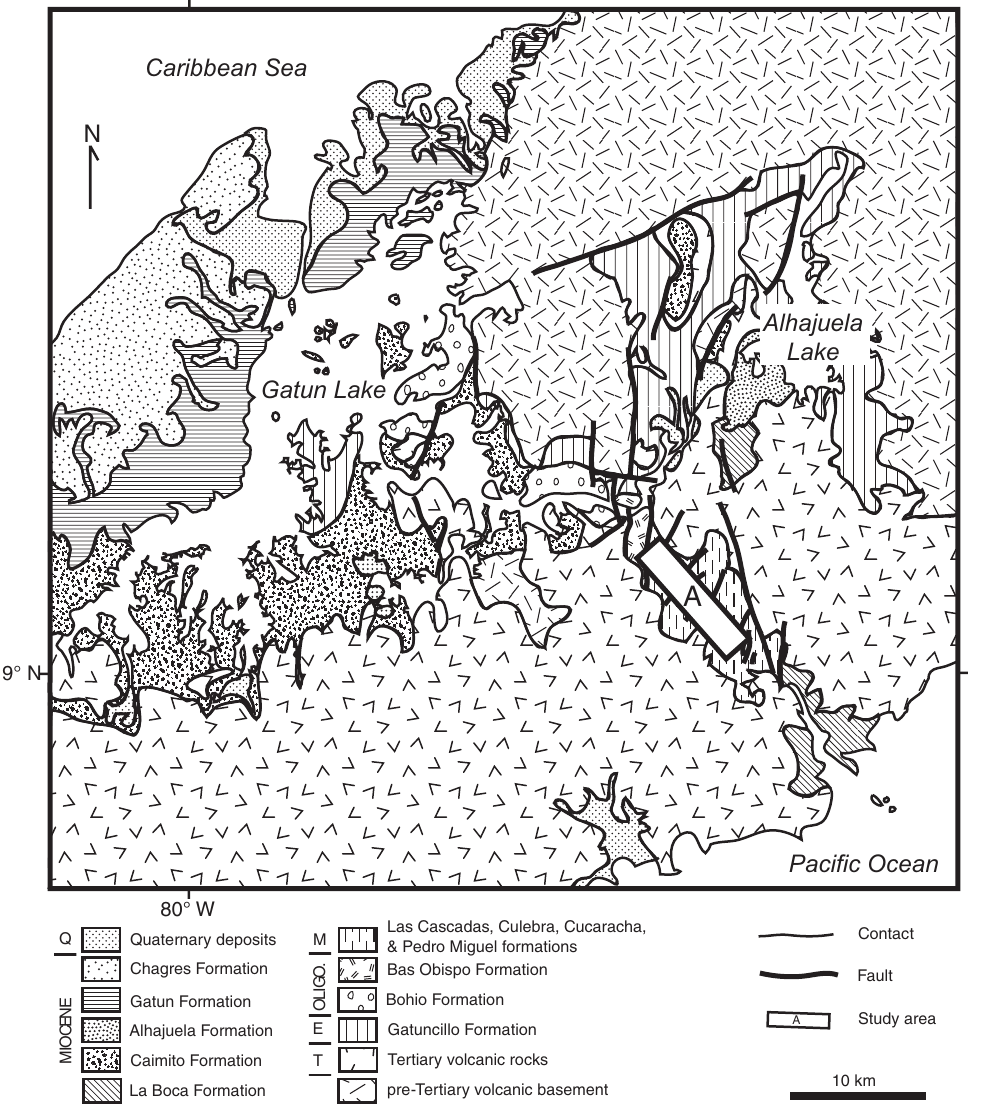
Figure 2. Geologic map of the Panama Canal Basin showing the study area (A) in relation to rock units discussed in the text. Geology modified from Stewart et al. [27]. Q=Quaternary. M=Miocene. Oligo.=Oligocene. E=Eocene.